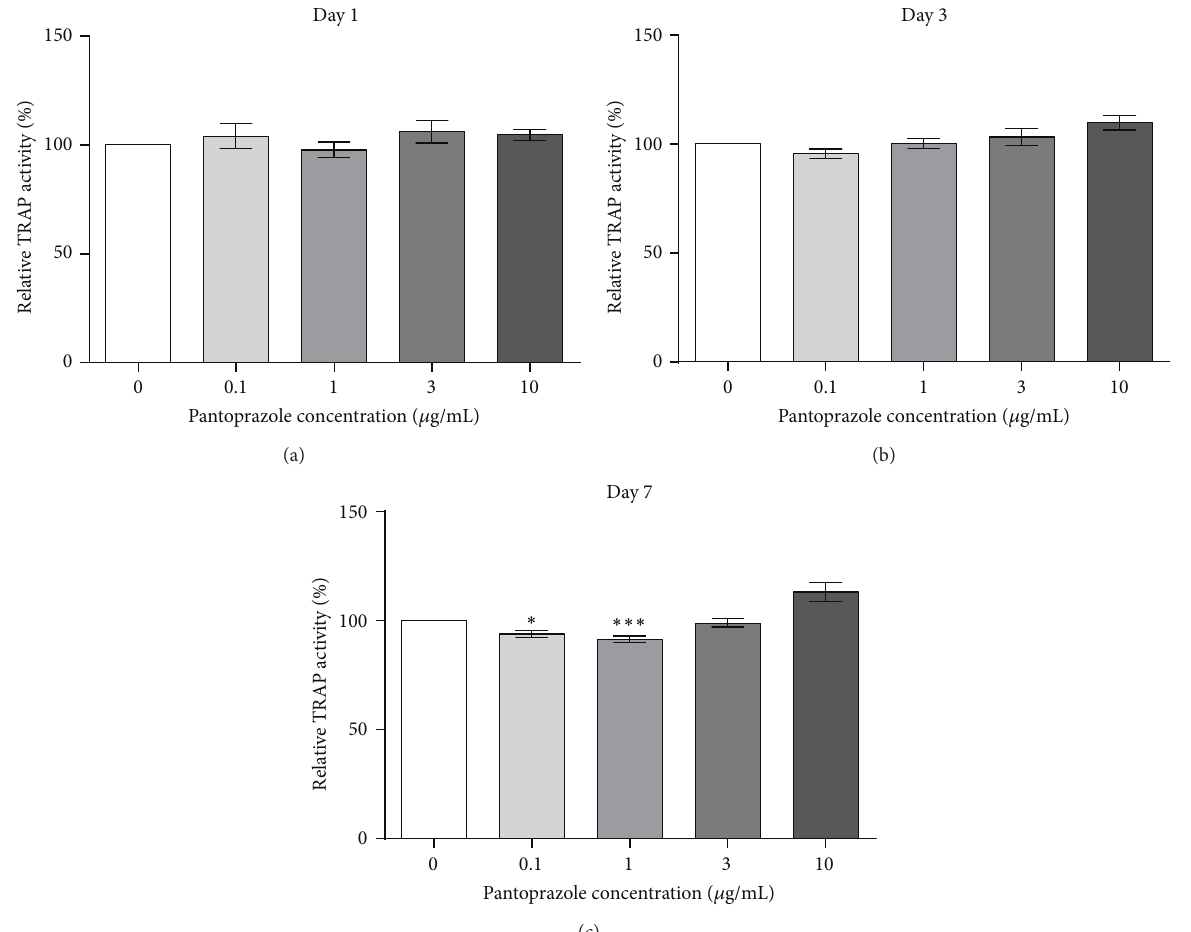
Figure 4: The relative TRAP activity of osteoclast samples ( 𝑁 = 4 , 𝑛 = 6 ), that is, the activity of samples stimulated with pantoprazole normalized to untreated samples, was assessed on days 1, 3, and 7 of stimulation. The results were accordingly expressed as a percentage of the negative control. Shown are column bar graphs of means ± SEM. ∗ 𝑃 < 0.05 and ∗∗∗ 𝑃 < 0.001 versus the untreated